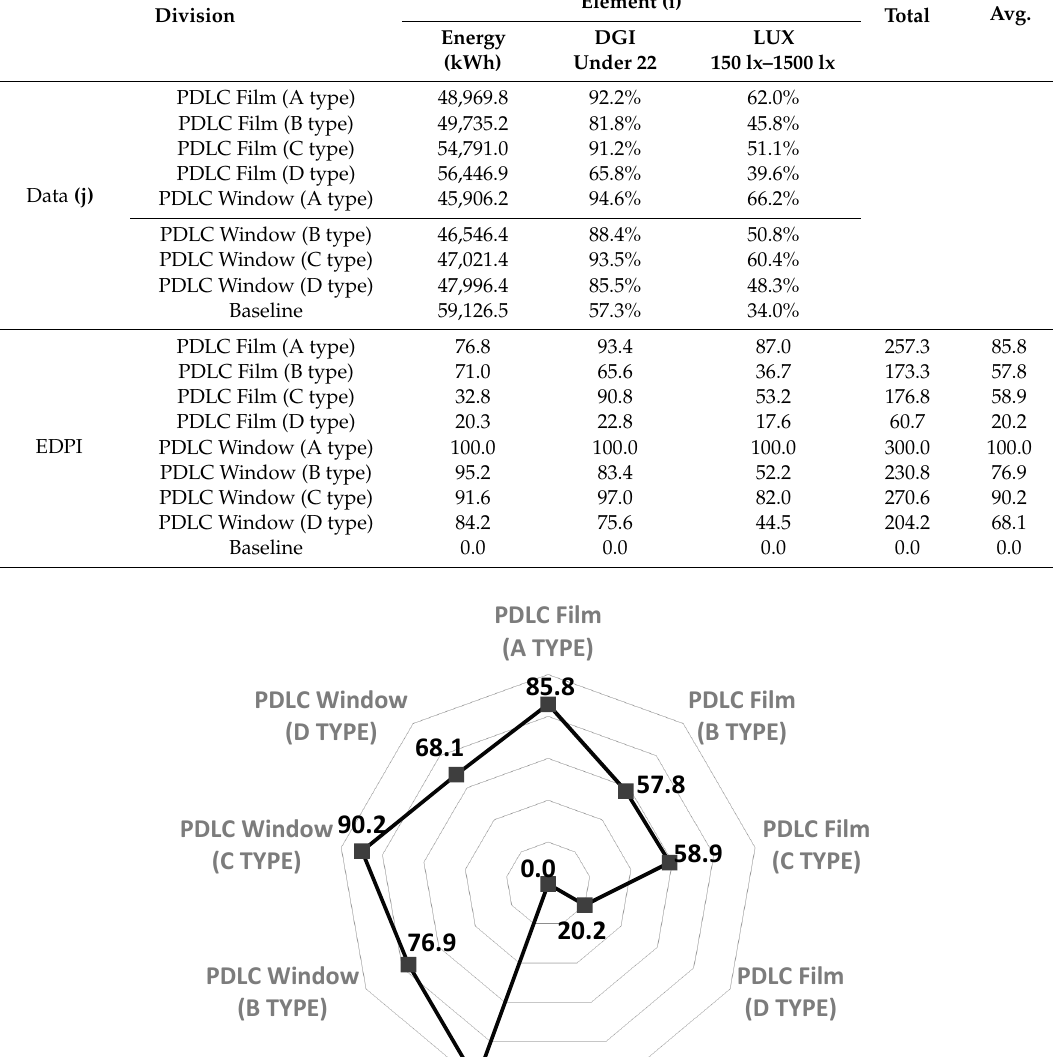
Table 17. Integrated energy and daylight performance evaluation data analysis through the Integrated Energy and Daylight Performance Index (EDPI).